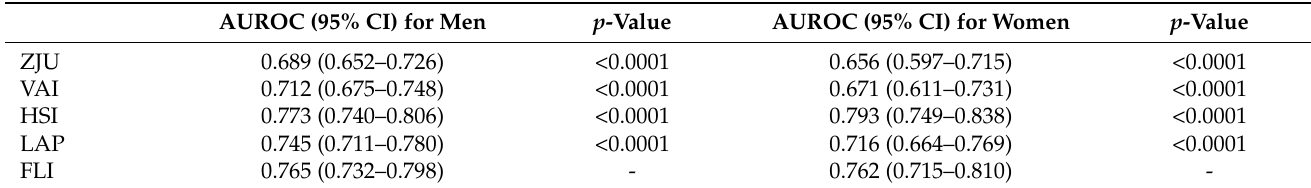
Table 4. Sex differences in the diagnostic accuracy of ZJU, VAI, HSI, LAP, and FLI.